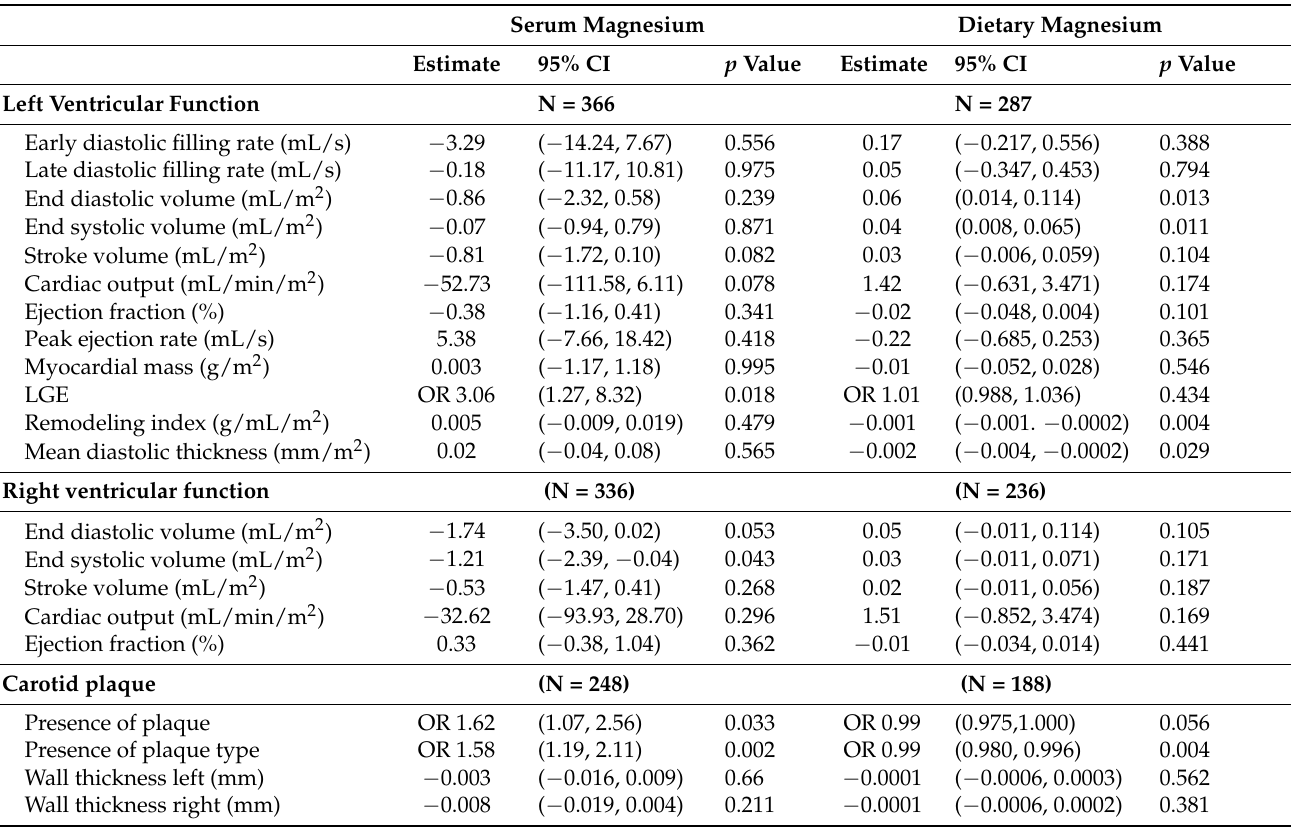
Table 3. Results of multivariable-adjusted models for the relation between serum and dietary magnesium and imaging markers of subclinical cardiovascular disease.